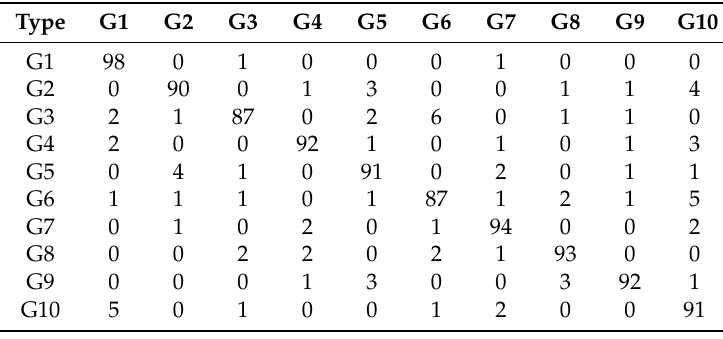
Table 4. Recognition rate with Cosine correlation coefficient distance.